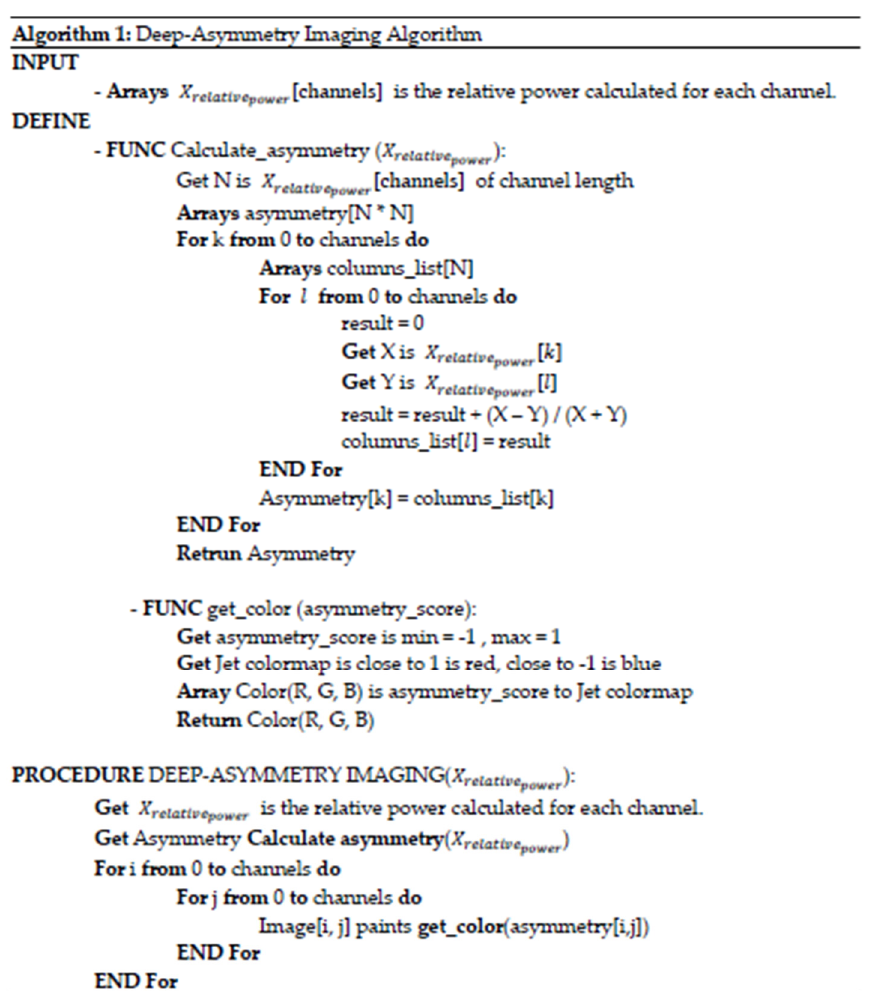
Figure 5. Deep-asymmetry matrix imaging algorithm.